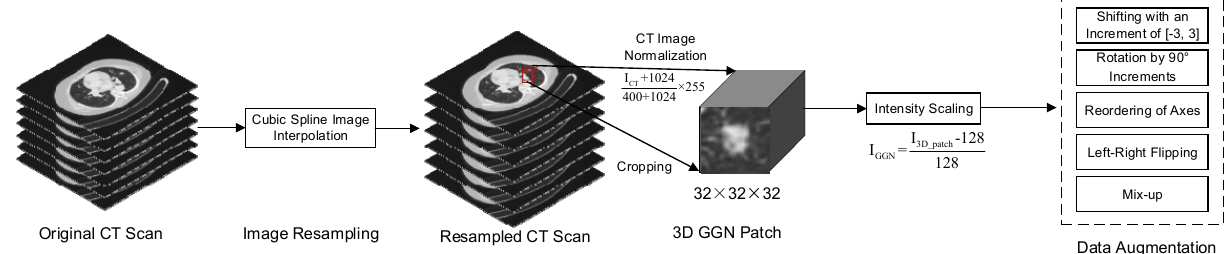
Figure A1. The flowchart of image pre-processing step.